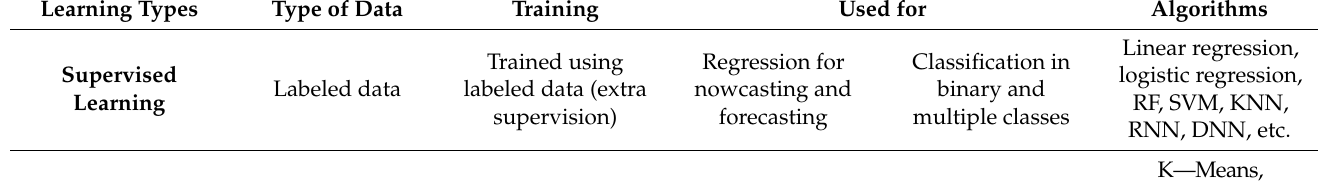
Table 2. Comparison of supervised, unsupervised, and reinforcement learning algorithms.